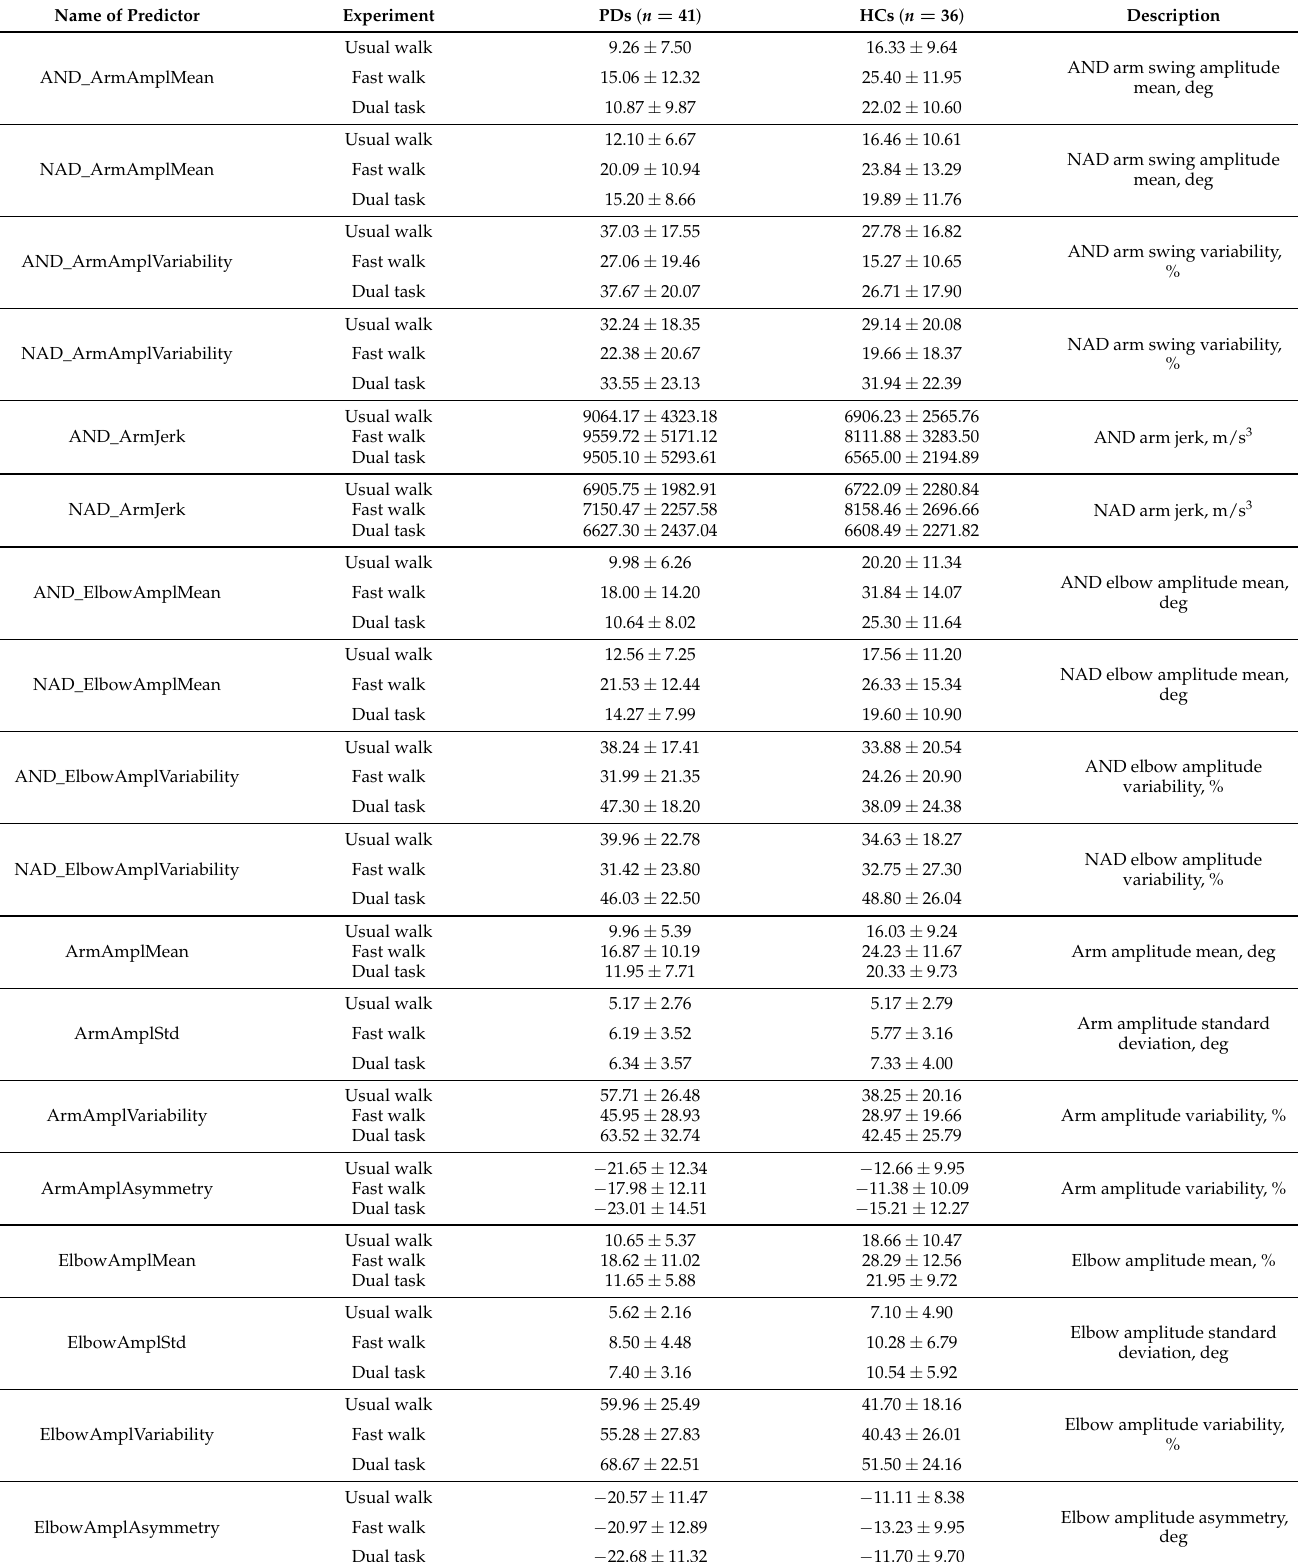
Table A3. Arm-related predictors (mean and SD values, shown as mean ±